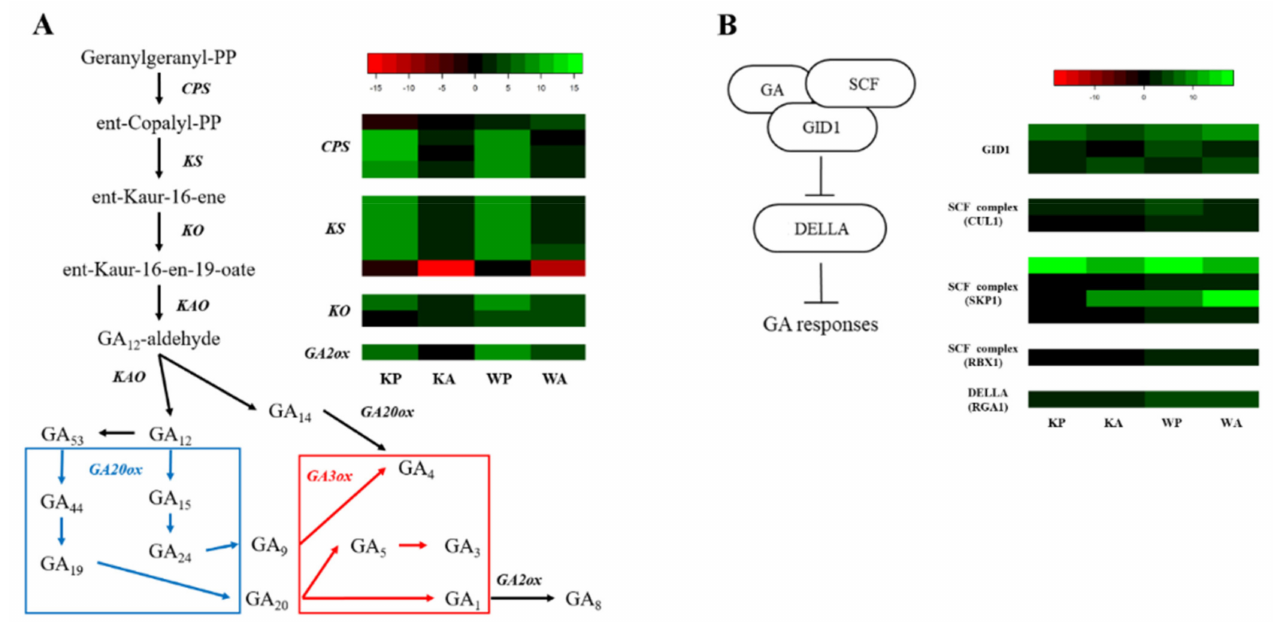
Figure 3. Heat map analysis of DEGs from PHS and ABA treatment for gibberellic acid (GA) hormone metabolism and signaling: ( A ) hormone metabolism pathway of GAs and comparative expression of genes related to GAs hormone metabolism. All the process in blue box and red box are catalyzed by GA20 ox and GA3 ox, respectively; ( B ) Signaling pathway of GA and comparative expression of genes related to GA signaling. The heatmap shows an expression change compared to the controls for each cultivar, with log2 fold-change